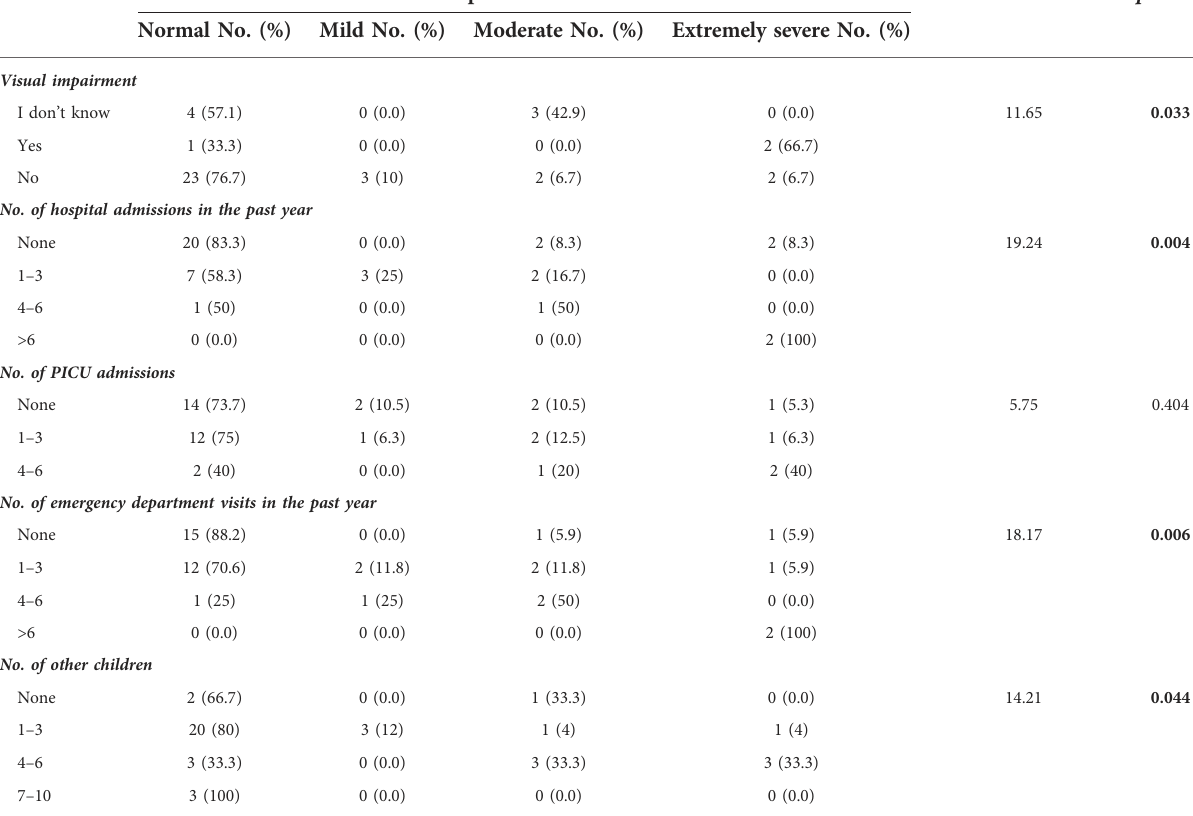
TABLE 3 Relationship between depression status and child health status. Variable Depression status Fisher ’ s Exact test p -value Normal No. (%) Mild No. (%) Moderate No. (%) Extremely severe No.